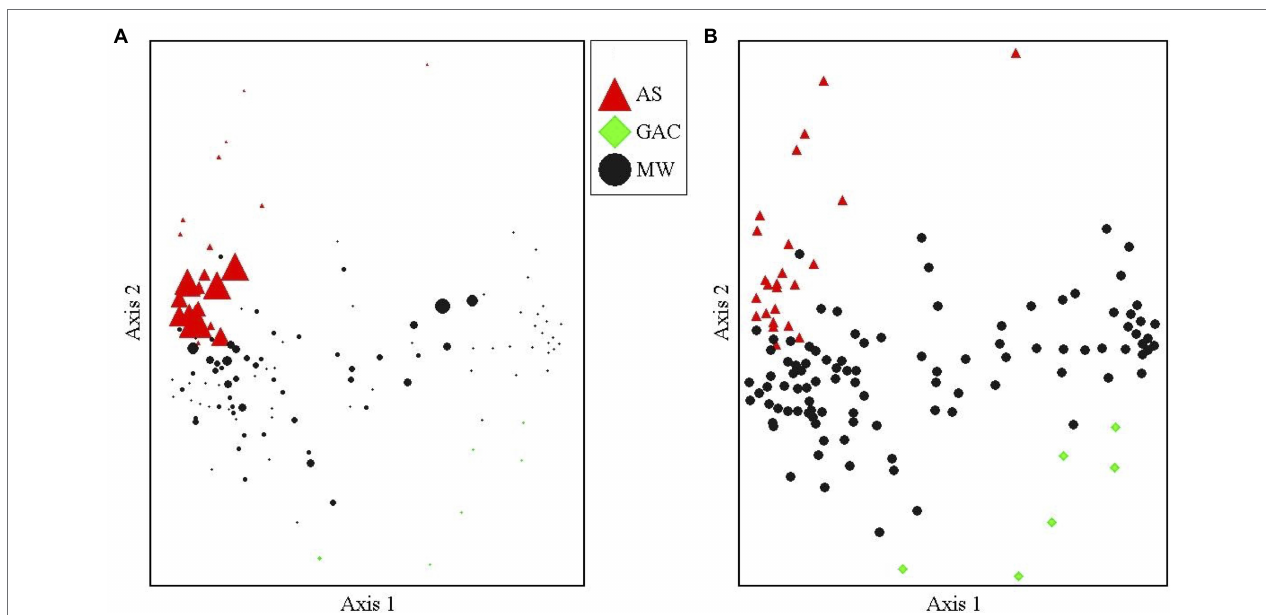
FIGURE 2 | NMDS of the aquifer monitoring well (MW), air sparge system (AS), and GAC microbial communities. (A) Marker size is proportional to the relative abundance of the sulfolane-assimilating Rhodoferax sp. in each sample. Largest size marker represents a 10.5% relative abundance and smallest represents 0% relative abundance. (B) Identical nonmetric multidimensional scaling (NMS) plot with equal marker sizes for each sample showing the microbial community group by sample type. A stable solution was reached after 58 iterations with an optimal dimensionality of two axes, a final stress of 18.6 and a final instability value of 0.00000. The proportion of variance explained by each axis was 36.7% for axis 1 and 16.9% for axis 2.